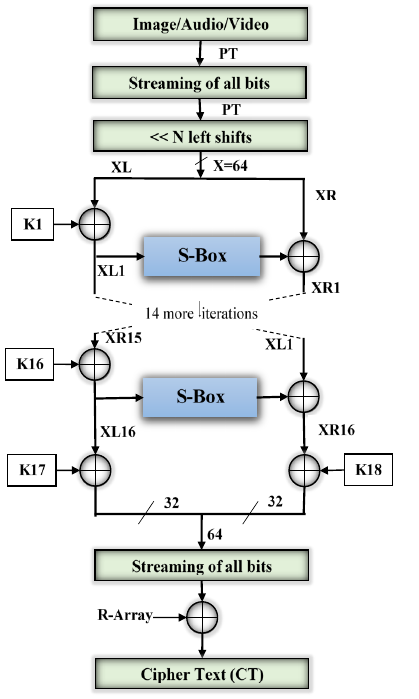
Figure 2. The Steps of Improved Hybrid Algo. [12]